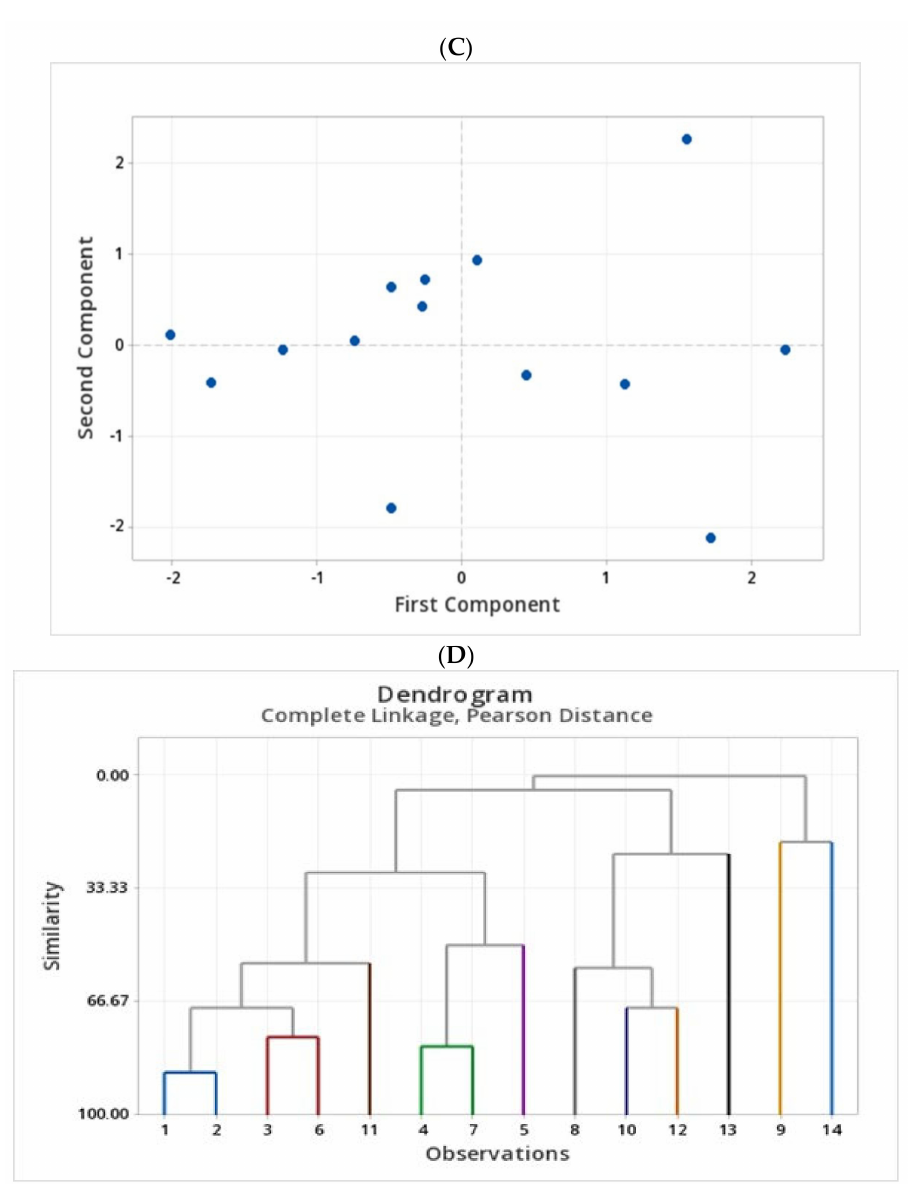
Figure 4. Principal component analysis and cluster analysis of the free form of phenolic compounds in barley genotypes from Table 1; ( A , B ) the loading plot: blue dots indicate each barley genotype tested; ( C ) the scree plot of principal component analysis for FA, PCA, CAF, SIN, Iso FA, CAT, 4HBA, and VAN A; ( D ) dendrogram from cluster analysis for FA, PCA, CAF, SIN, Iso FA, CAT, 4HBA, and VAN A of 14 barley genotypes. Observations left to right in order: 1 = AAC Synergy, 2 = AAC Goldman, 3 = AC Metcalfe, 6 = CDC Bow, 11 = Line 2, 4 = CDC Copeland, 7 = CDC Mindon, 5 = CDC Bold, 8 = Harrington, 10 = Line 1, 12 = Line 3, 13 = Line 4, 9 = Lowe, and 14 = Line